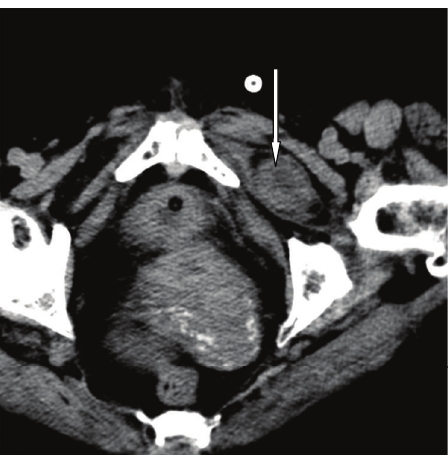
Figure 1: Computed tomography image showing a herniated bowel loop in the obturator foramen on the left.